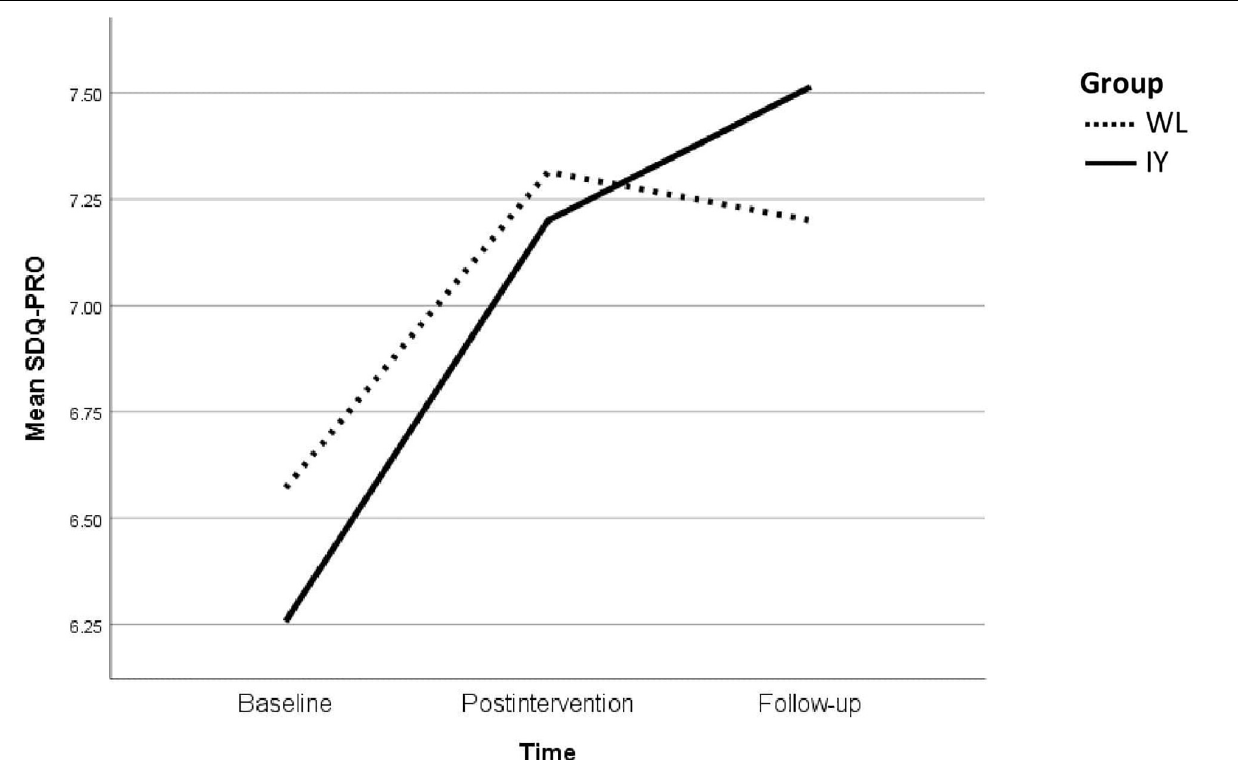
Frontiers in Psychology |